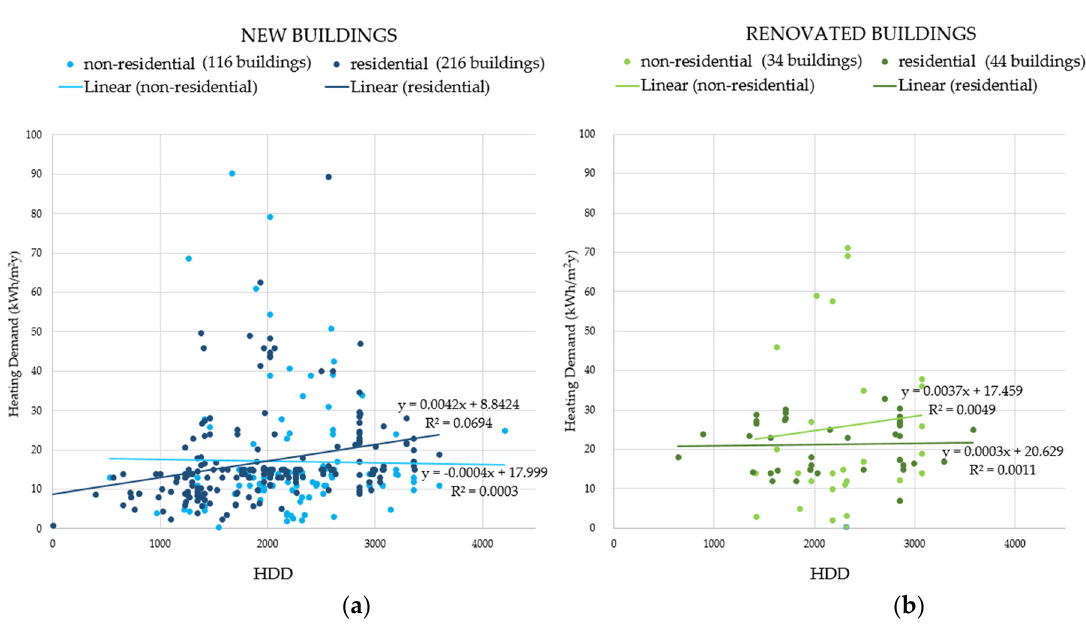
Figure 3. Heating demand of nZEBs in relation to the use of the buildings, as well as the construction type, new buildings ( a ) and renovated buildings ( b ) according to HDD (15 °C).